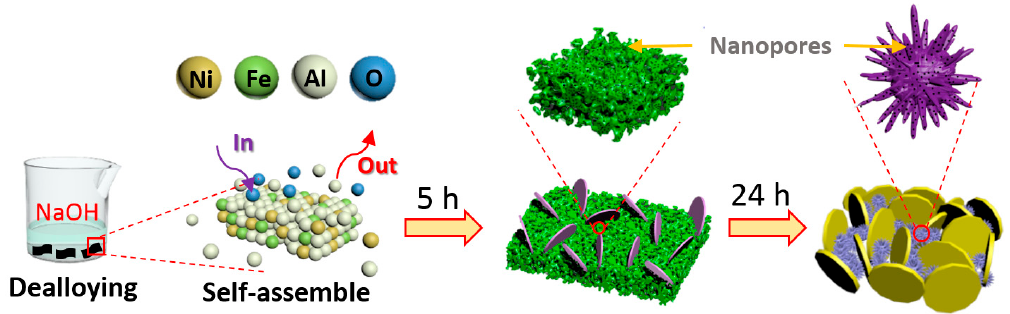
Figure 1. Schematic illustration showing the synthesis process of the dual-network nanoporous Fe 3 O 4 /NiO composites.